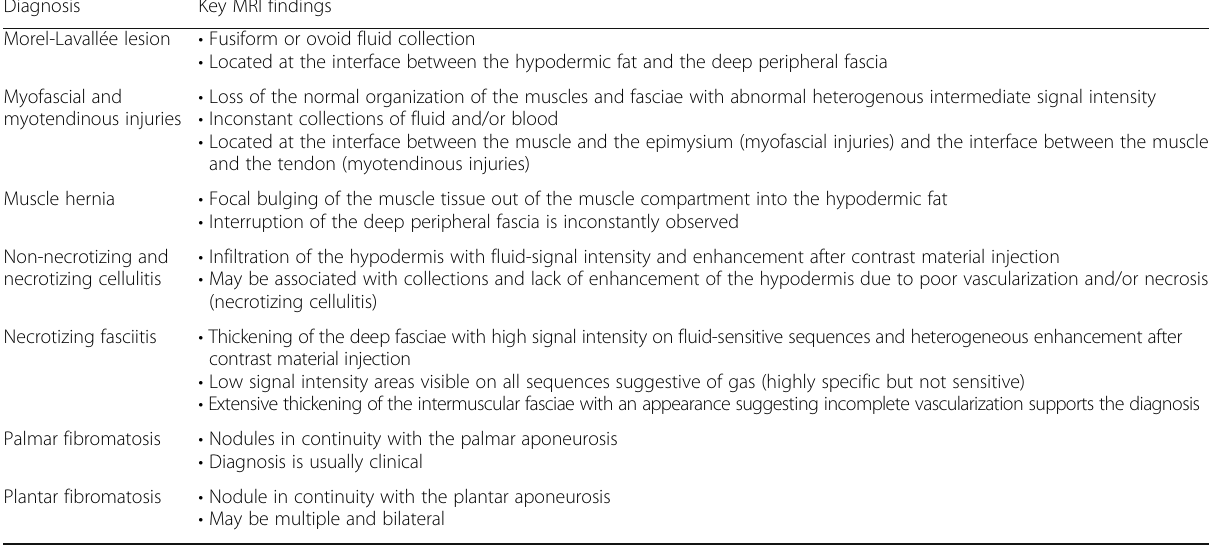
Table 1 Key MRI findings for the diagnosis of localized disorders of the fasciae Diagnosis Key MRI findings Morel-Lavallée